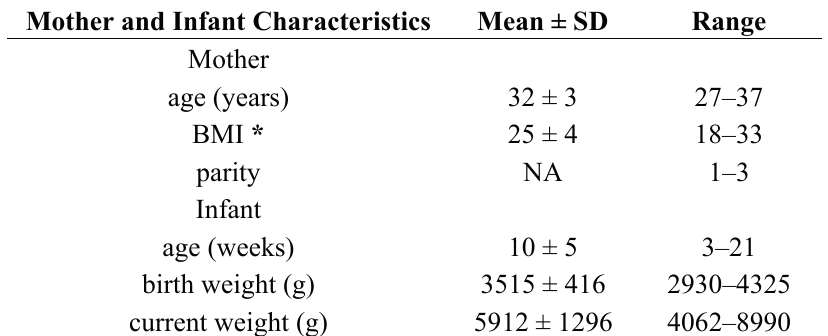
Table 1. Characteristics of the study cohort ( n = 19 breastfeeding